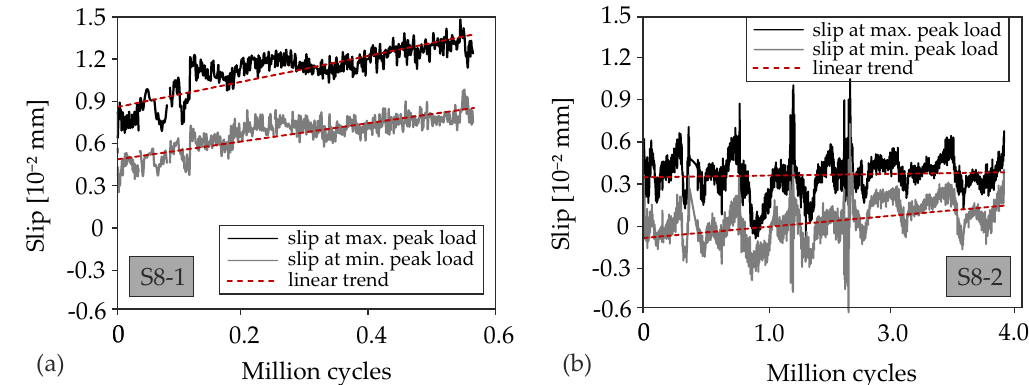
Figure 18. Measured development of the slip in the concrete interface compared to load duration of the cyclic tests: ( a ) shear test S8-1 and ( b ) flexural test